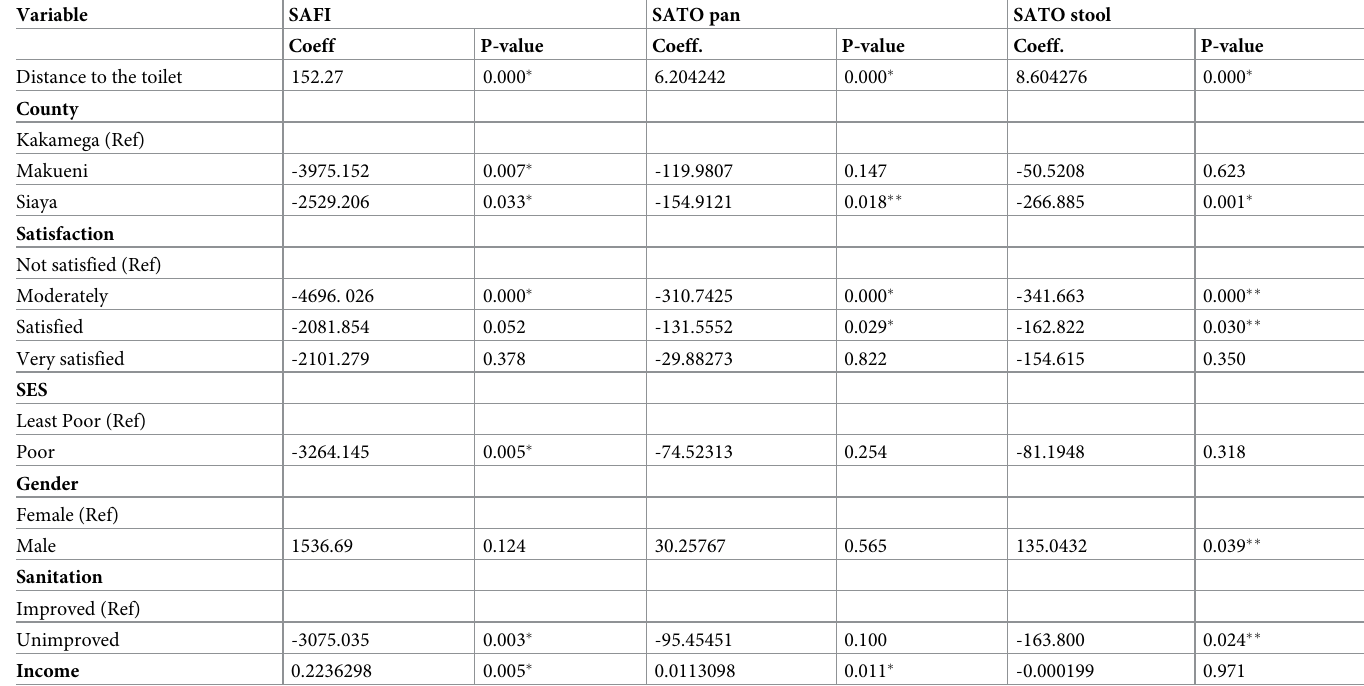
Table 3. Summary multivariate results on the determinants of WTP for sanitation products in